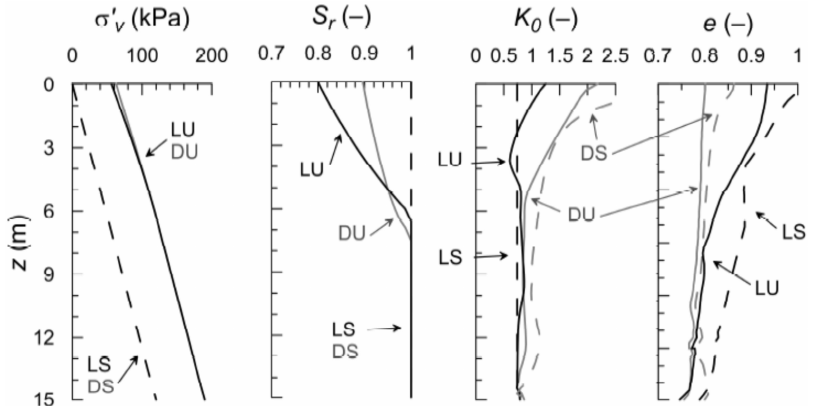
Figure 5. Initial condition for the three-dimensional models.